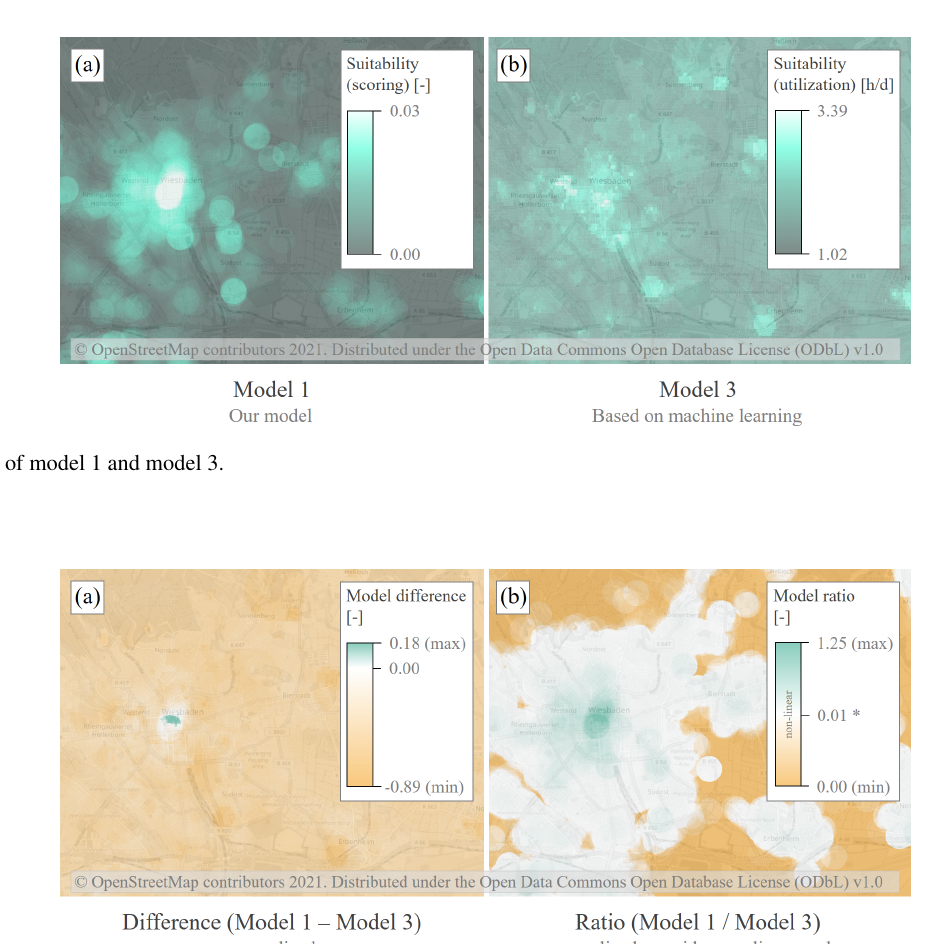
Figure 3. Model evaluation at 1000 random points.